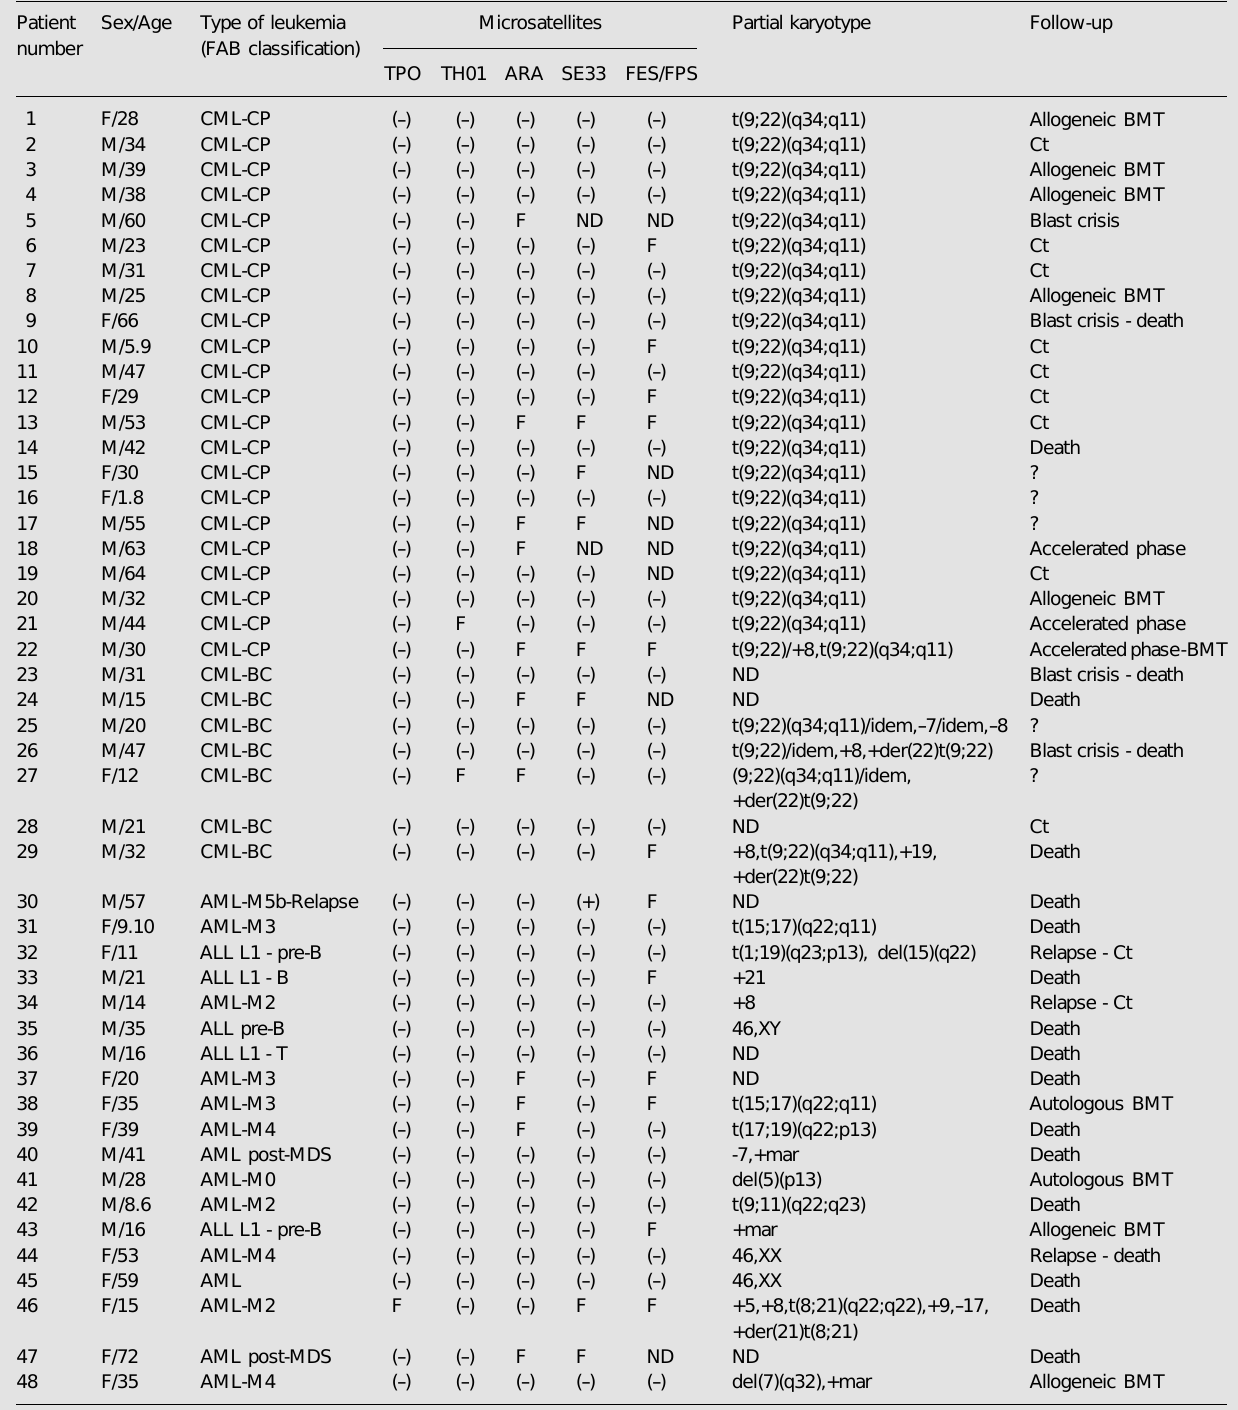
Table 2. Patient characteristics, microsatellite instability, cytogenetic analysis and